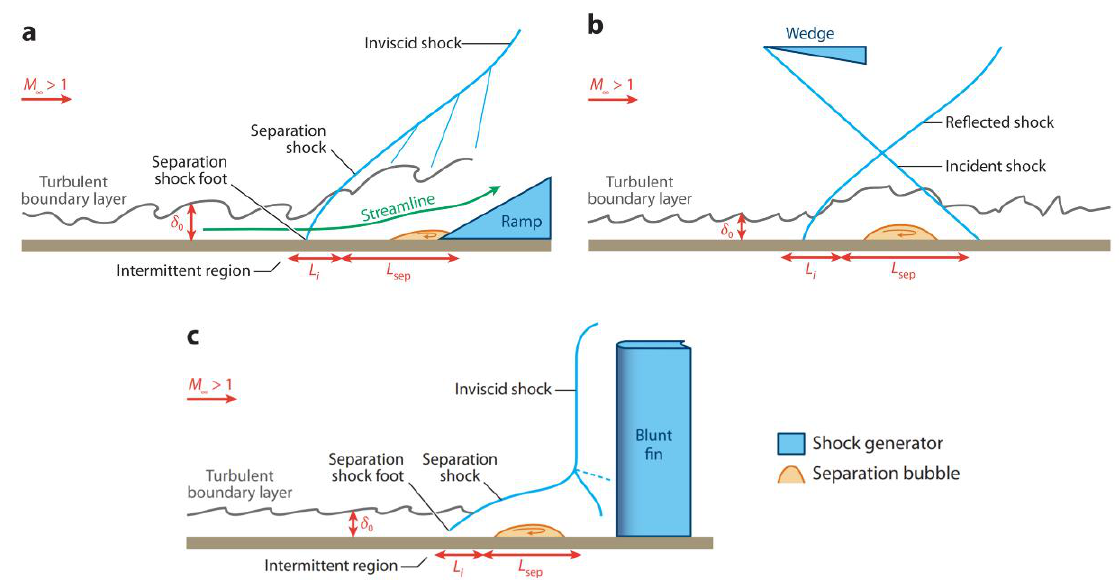
Figure 32. Schematic diagrams of the three typical shock wave/boundary layer interactions [45]: ( a ) compression ramp; ( b ) reflected shock; ( c ) blunt fin. Figure adapted with permission from Clemens et al. (2014). Copyright © 2014 Annual Reviews.